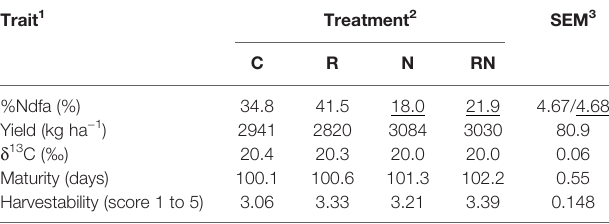
TABLE 2 | Treatment means for fi ve traits evaluated in 20 common bean genotypes at the Elora research station, ON in 2016 pilot study. Trait 1 Treatment 2 SEM 3